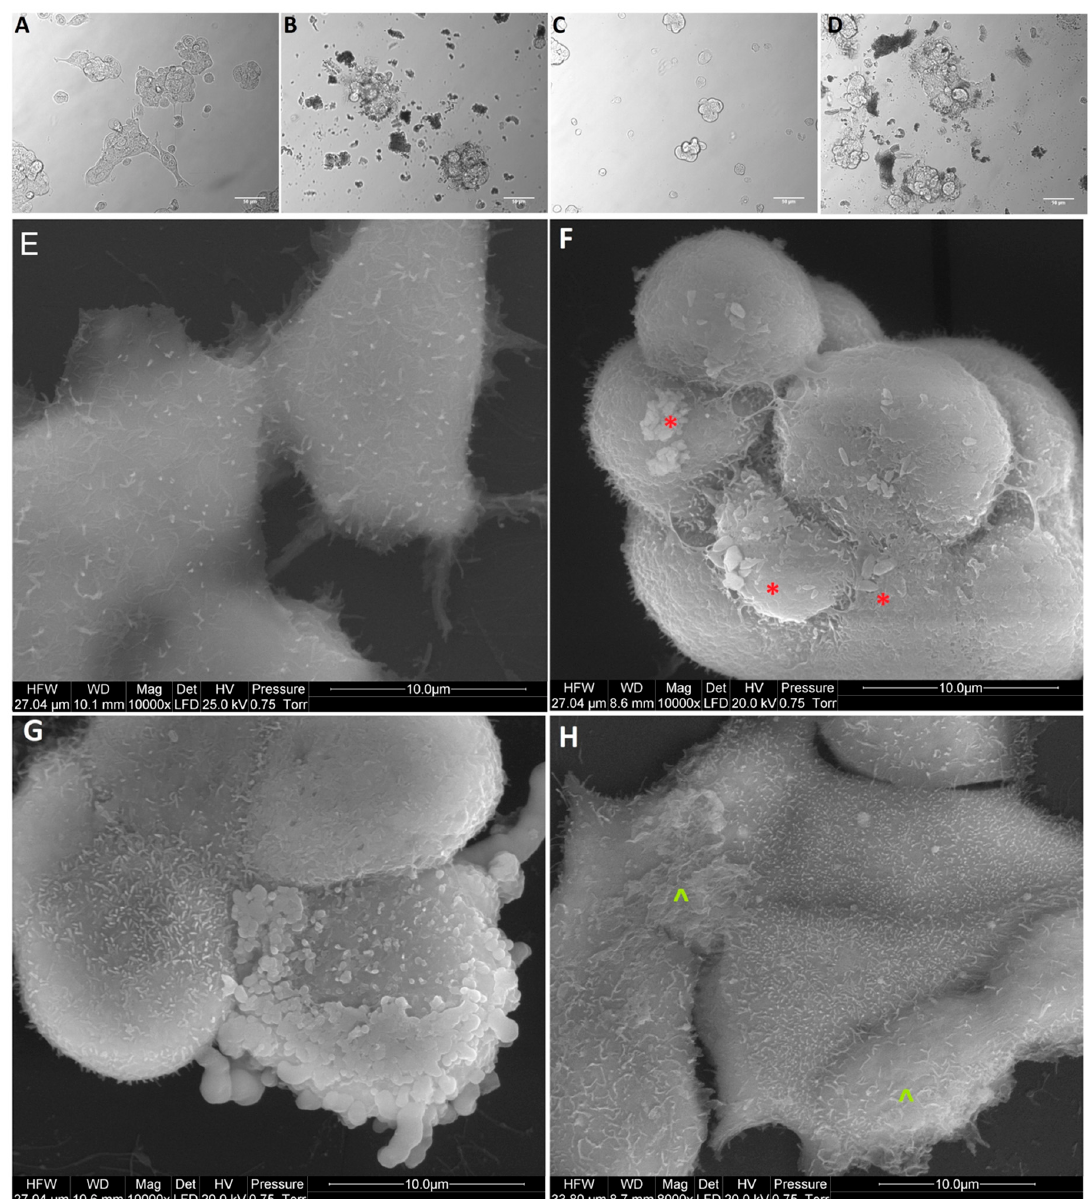
Figure 7. Morphology of MCF-7 breast cancer cells. ( A , E ) untreated cells (control group), ( B , F ) cells treated with nanocomplexes of graphene oxide with platinum nanoparticles (GO-NP-Pt), ( C , G ) cells treated with platinum nanoparticles (NP-Pt), ( D , H ) cells treated with graphene oxide (GO). Red *— point on GO-NP-Pt at cell membrane. Green ^— point on GO at cell membrane. ( A–D ) Light optical